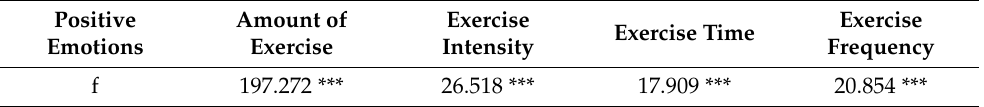
Table 4. The significance test of positive emotions in physical